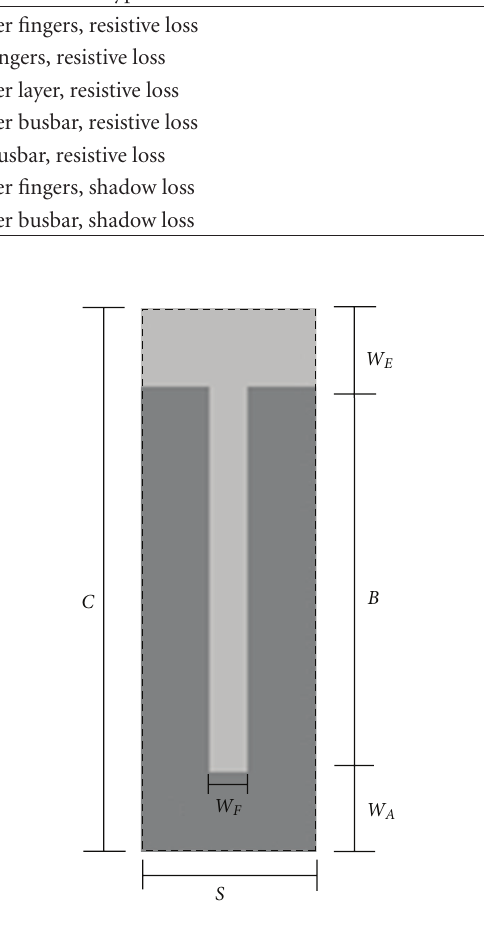
Figure 4: A sample unit cell of an interdigitated thin-film solar cell. B is the C is the total cell width, W E is the emitter busbar width, emitter/BSF finger length, W A is the BSF busbar width, S is the (cen- tre-to-centre) emitter finger spacing, and W F is the emitter finger